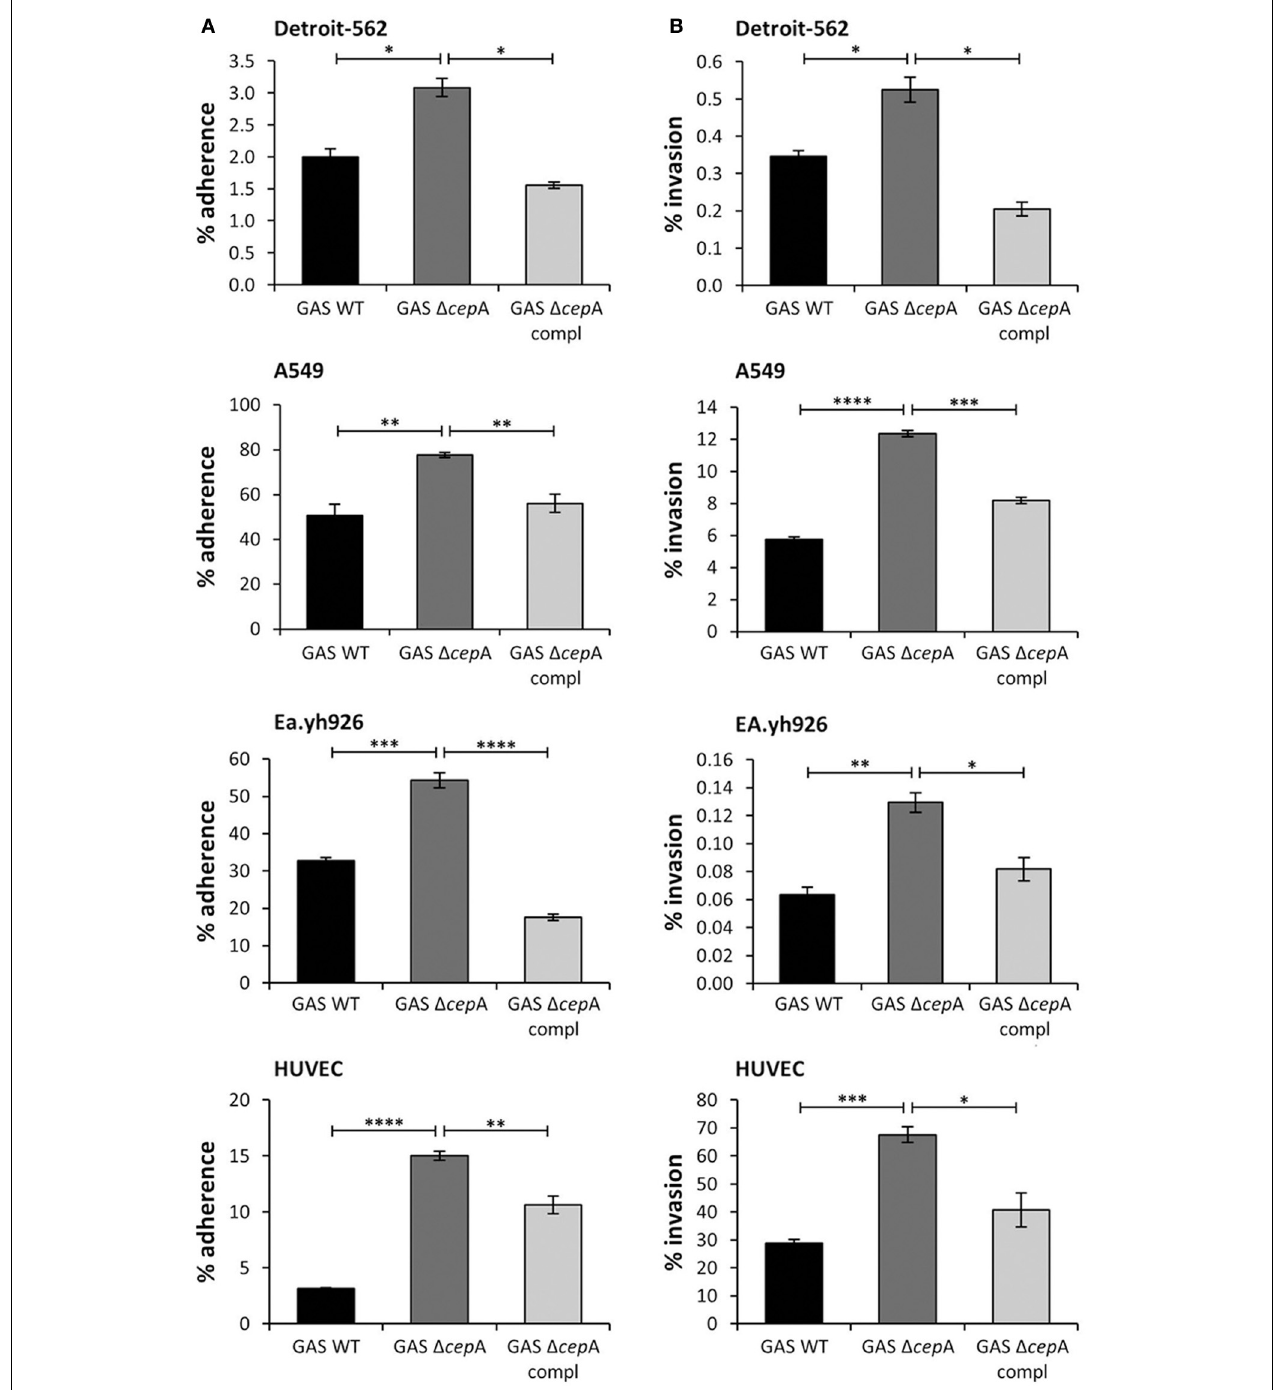
FIGURE 1 | Enhanced GAS adherence to and invasion of epithelial and endothelial cells in the absence of SpyCEP. The epithelial cell lines Detroit-562 and A549 and the endothelial cells Ea.hy926 and HUVECs were challenged with the GAS strains GAS WT, GAS (cid:2) cepA , and GAS (cid:2) cepA compl. MOI of 1 was used for adherence assays and MOI of 10 was used for invasion assays. To assess adherence and invasion an antibiotic protection assay was used and adhering/invading bacteria enumerated by plating and